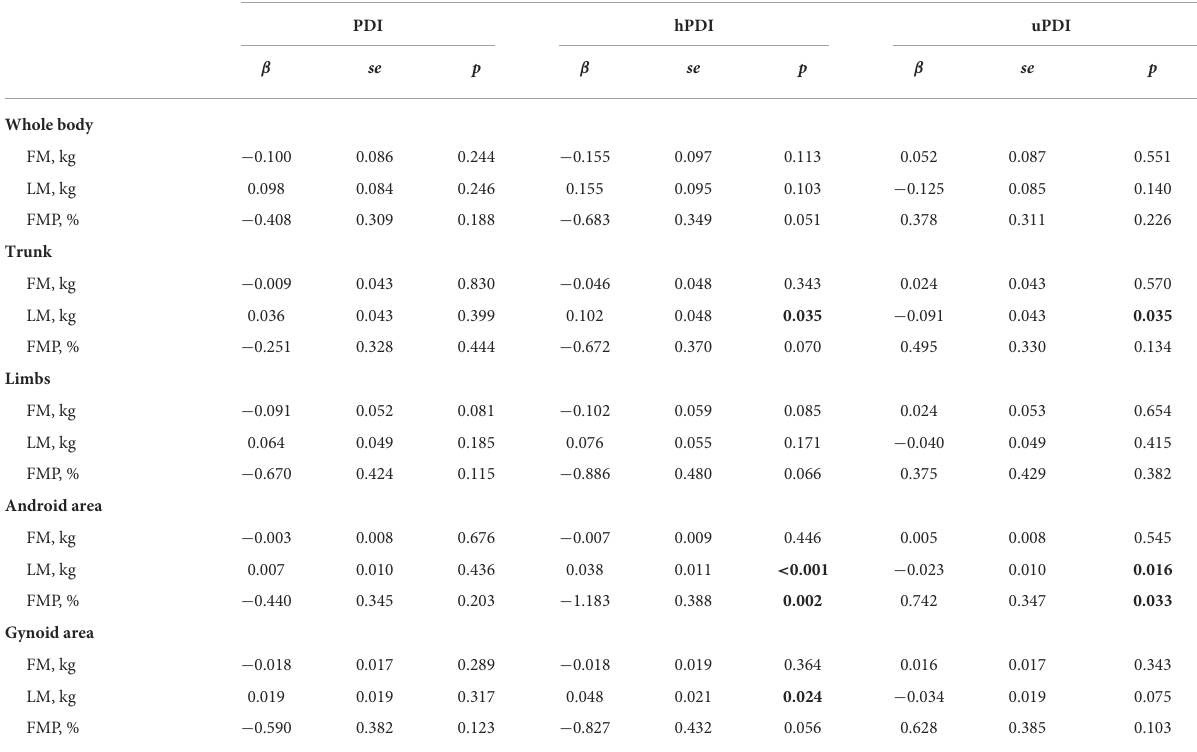
TABLE 3 Associations of plant-based diet index scores with body composition after adjusted for potential covariates. Body composition Per 10-score increment of plant-based diet